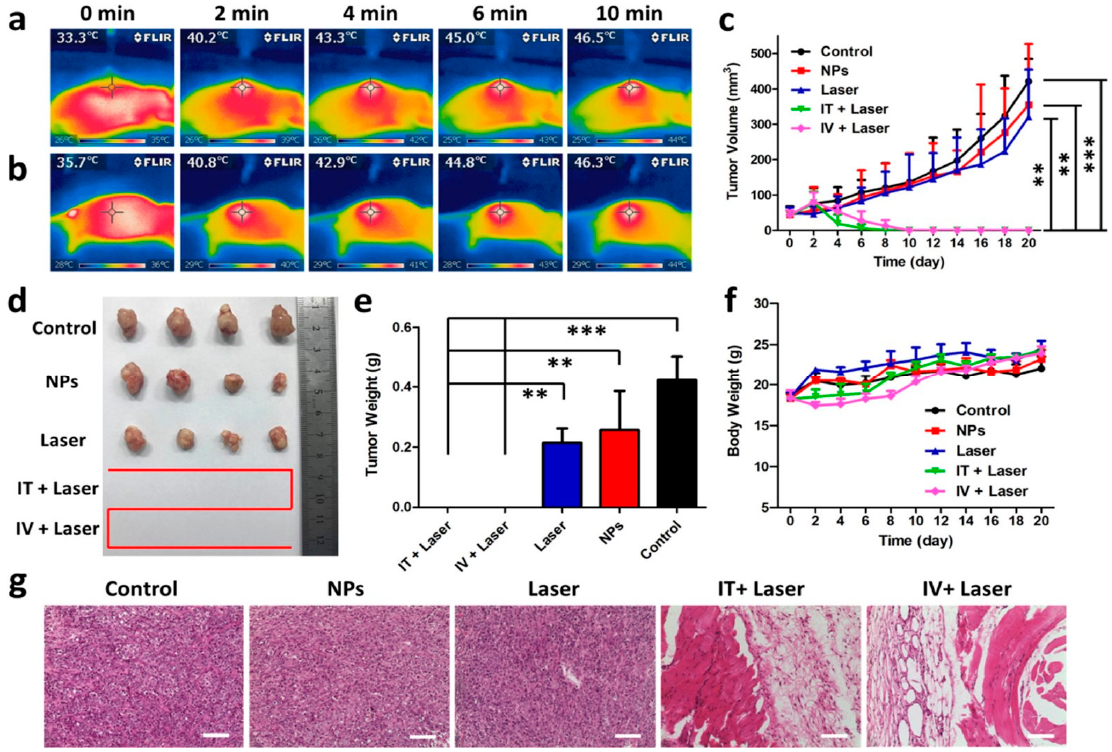
Figure 3. The NIR ‐ II photothermal approach by a novel nanoagent. In vivo photothermal therapy of tumors. Mice were subjected to whole ‐ body IR images after injection with a narrow band gap D–A conjugated polymer (TBDOPV–DT), with 2,2 ‐ bithiophene as the donor and thiophene ‐ fused benzodifurandione ‐ based oligo( p ‐ phenylenevinylene) as the acceptor. ( a ) Intratumoral (0.56 mg kg –1 , 0.9 W cm − 2 , and a 1064 nm laser) or ( b ) intravenous (1.94 mg kg –1 , 1.3 W cm − 2 ) administration. ( c ) Growth rates of tumors after different treatments. ( d ) Representative size of the excised tumors. ( e ) Weight of tumor in each condition. ( f ) Changes in body weight of the mice with tumors. ** p ≤ 0.01; *** p ≤ 0.001. ( g ) H&E staining of tumor regions in different groups. Scale bars indicate 100 μ m. Reproduced from [76] with permission, copyright American Chemical Society, 2018.